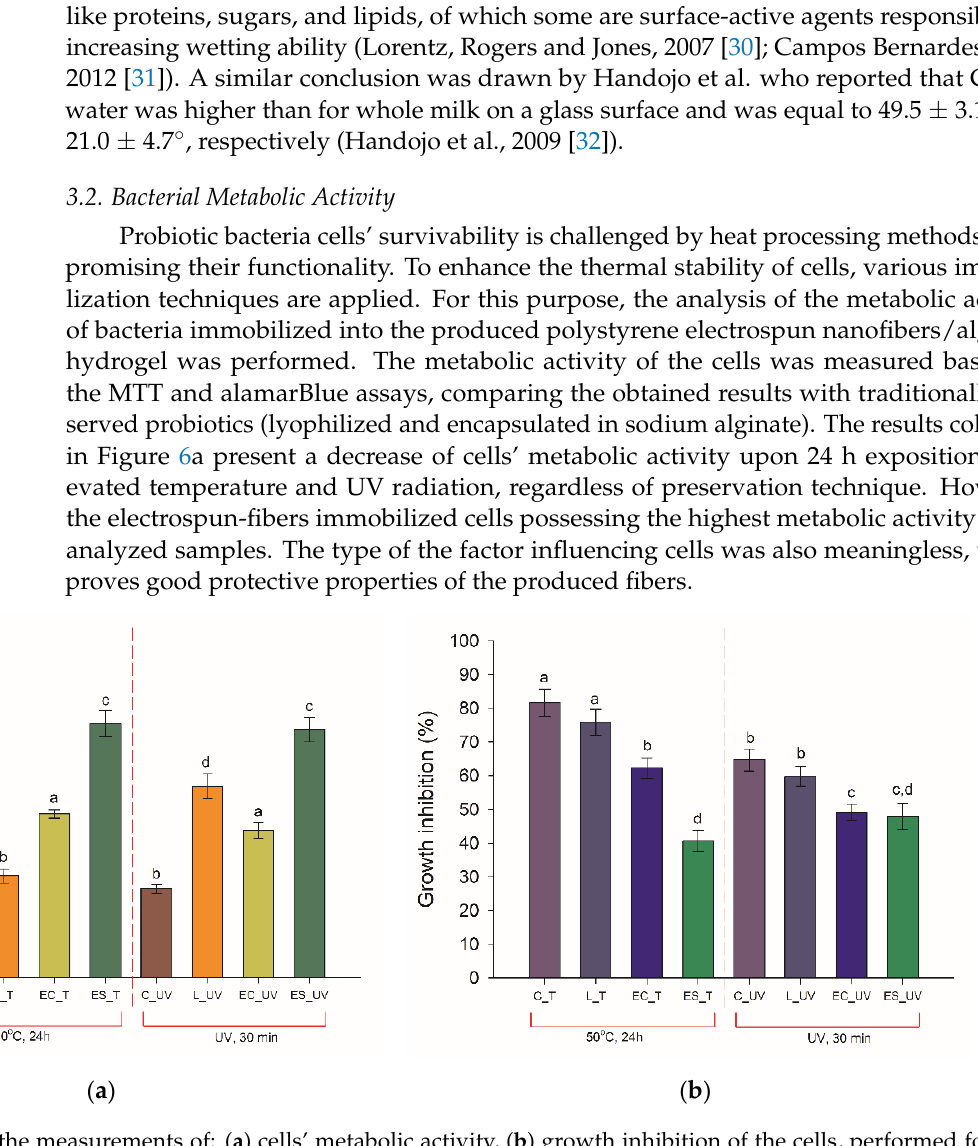
Figure 6. Results of the measurements of: ( a ) cells ’ metabolic activity, ( b ) growth inhibition of the cells, performed for control (C), lyophilized (L), alginate hydrogel-encapsulated (EC), and electrospun fibers immobilized (ES) cells of L. plantarum 2675 exposed to increased temperature (50 ◦ C, 24 h) or UV radiation ( λ = 253 nm, 30 min). Error bars represent the standard error of the mean of the three replicates in three independent experiments. Different lowercase letters suggest the significant differences among mean values for each treatment group ( t -test; p < 0.05).